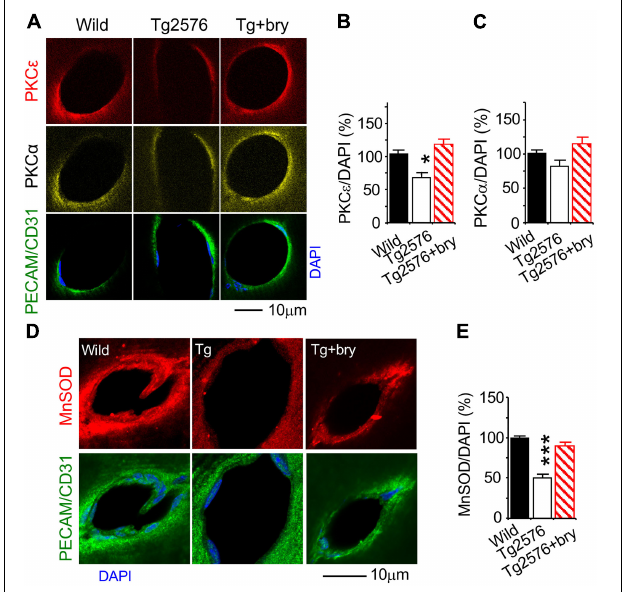
FIGURE 9 | The PKC ε activator protects a reduction of PKC ε and MnSOD in the hippocampal CA1 area from Tg2576 transgenic AD mice. Mice at 2 months of age were injected (i.p., twice a week) with normal saline in the presence or absence of bryostatin (30 µ g/kg body weight) for a 3-month period. Mice were then studied at the age of 5–6 months old when an increase in soluble amyloid-beta (A β ) and memory defect were seen in the hippocampus of Tg2576 mice (Hongpaisan et al., 2011). Bryostatin was withdrawn for 2 weeks to avoid the acute effect of bryostatin. Double immunohistochemistry and confocal microscopy of (A,B) PKC ε , (A,C) PKC α , and (D,E) MnSOD in vascular endothelial cells that were marked with PECAM/CD31. Bryostatin (bry) prevented the loss of PKC ε and MnSOD and promoted PKC α in Tg2576 (Tg) mice. Data are represented as mean ± SEM, * p < 0.05; *** p < 0.001; one-way ANOVA and post hoc Tukey’s multiple comparison test. ( n = 35–74 random MV cells from 3 to 5 mice/group).